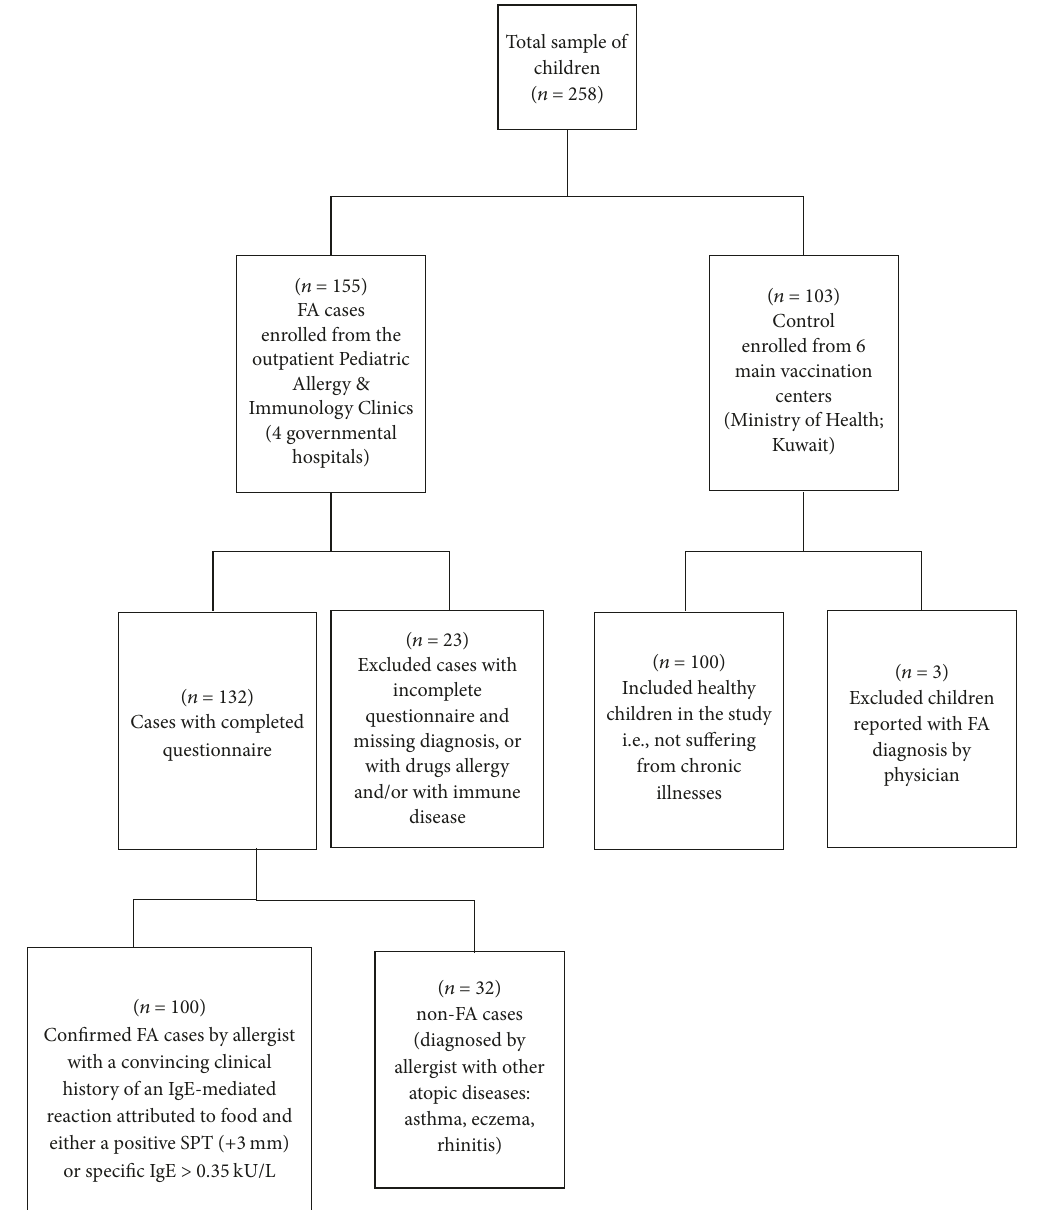
Figure 1: Flow chart of participants’